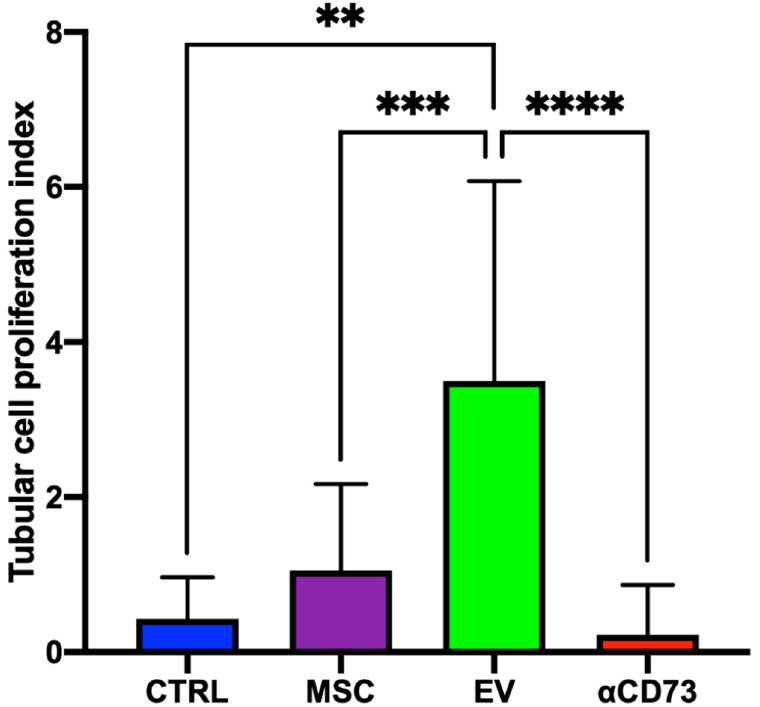
Figure 6. Tubular cell proliferation index. The tubular cell proliferation index (IPT) was defined as the ratio between nuclei expressing proliferating cell nuclear antigen and the total nuclei in each tubule in every field analyzed ( × 40). Data are expressed as mean and standard deviation. ** p < 0.01; *** p < 0.001; **** p < 0.0001. CTRL, control; MSC, mesenchymal stromal cell; EV, extracellular vesicle; α CD73, CD73-silenced group. N = 10 sections from each kidney were analyzed.